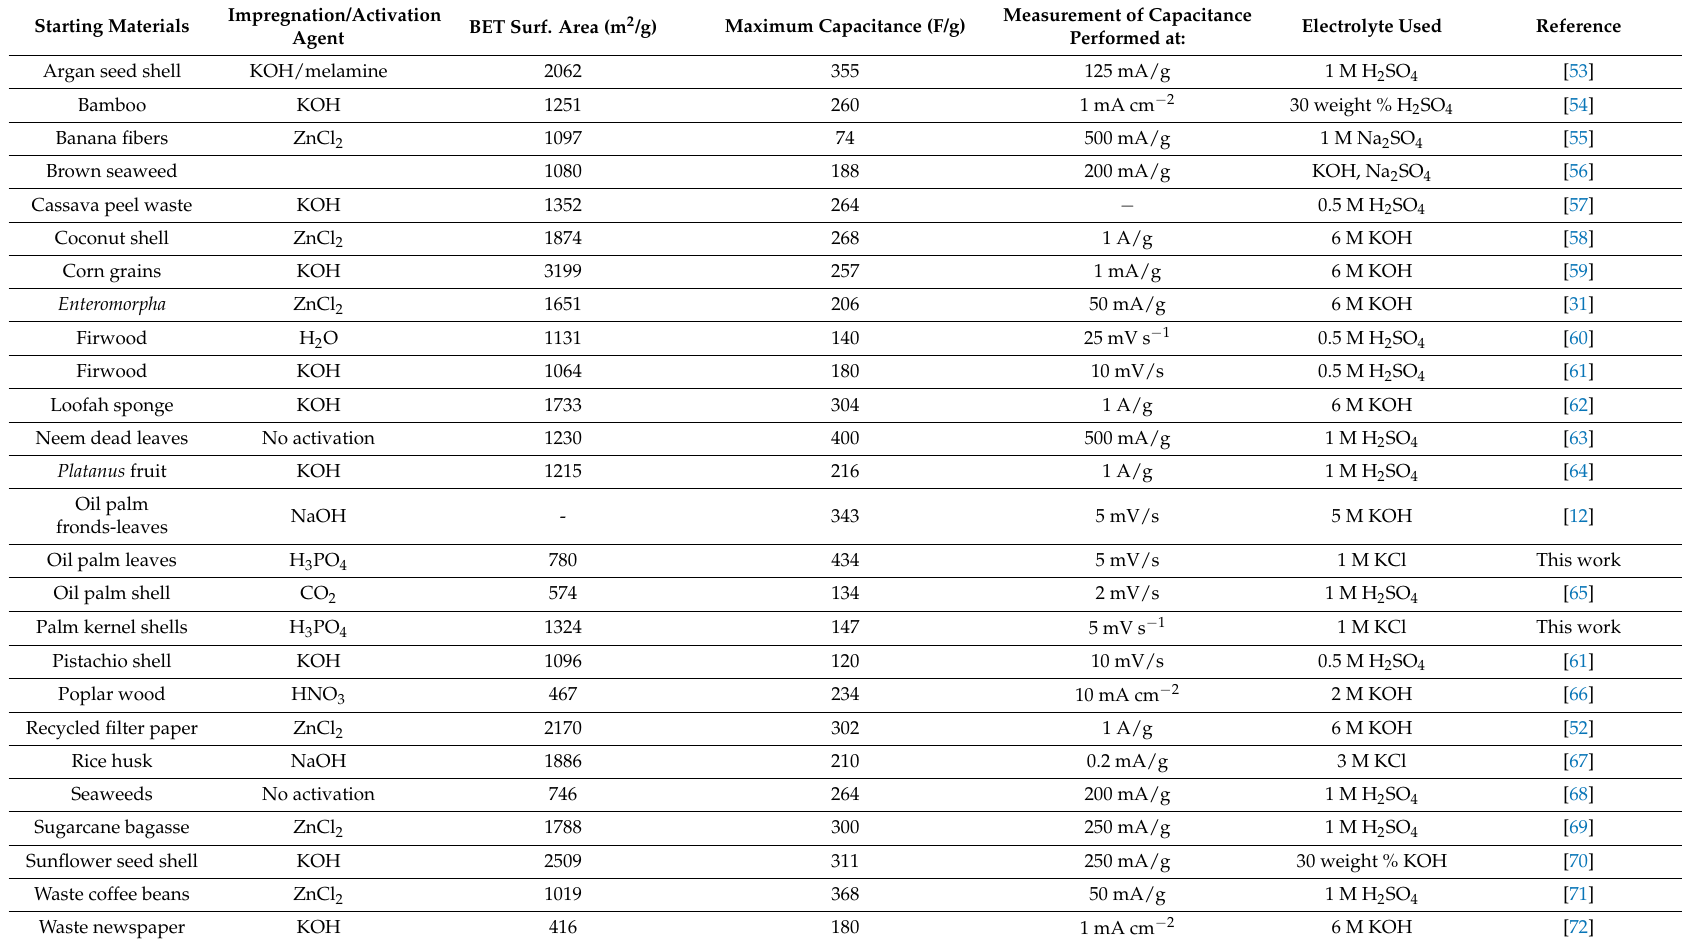
Table 2. Literature description combined with a comparative review of the features of various carbon-based materials, fabricated from waste biomass, and the application of their